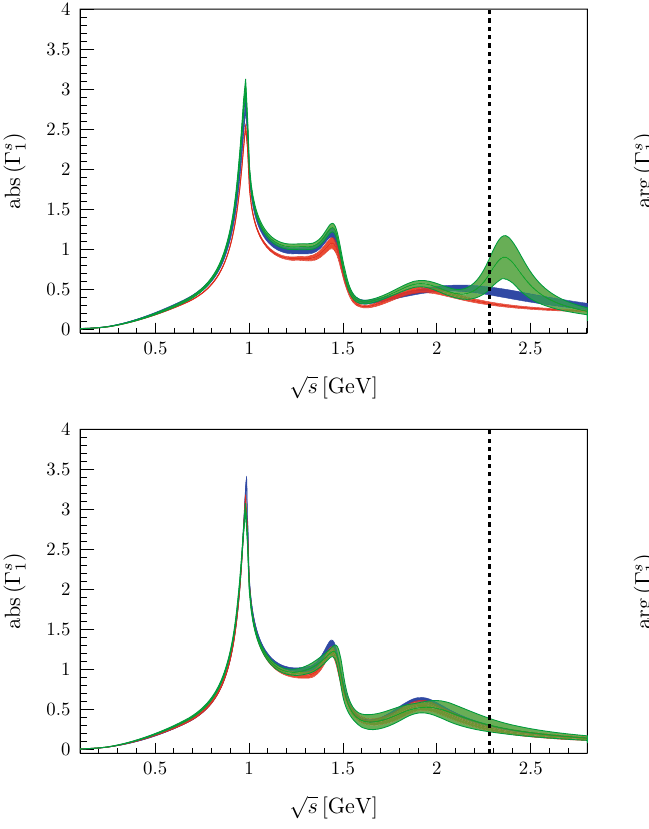
for in blue, Fit 2 in red, and Fit 3 in green. The dotted vertical lines mark √ 1 s in the ¯ B 0 s the kinematic upper limit for